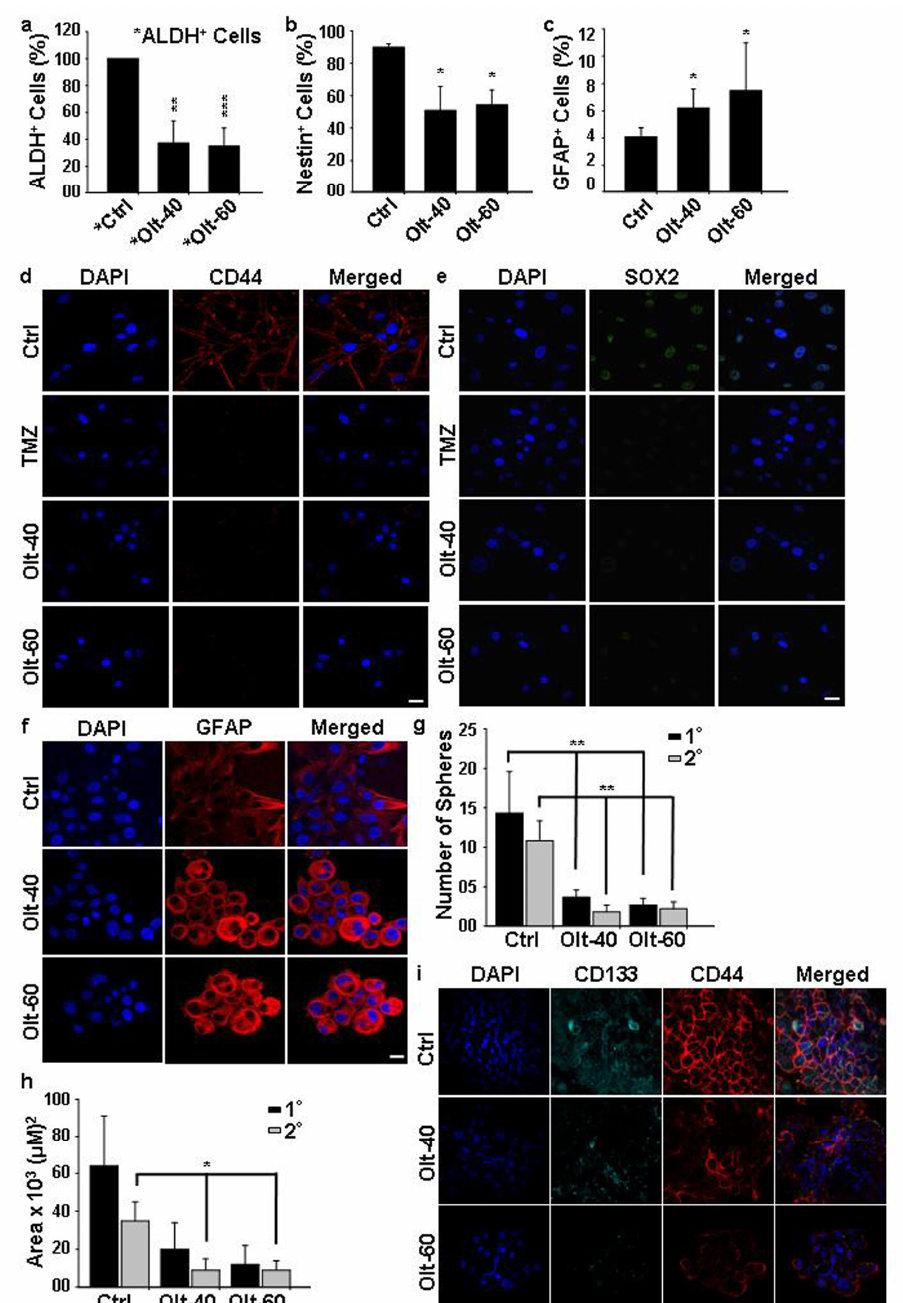
Figure 4. Influence of Olt on GSC population in vitro: ( a ) The ALDH + cells representing the GSCs pool from U-87 MG cells, following their purification by FACS and reseeding, displayed a significant reduction in ALDH + cells upon their exposure to the Olt for 48 h. ( b , c ) Olt exposure of U-87 MG cells for 48 h in culture decreased the number of Nestin + cells ( b ) but increased the GFAP + cells (c ). ( d , e ) The immunostained pattern also revealed a reduction in U-87 MG cells exhibiting stem cell markers such as CD44 ( d ) and SOX2 ( e ) expression upon Olt exposure. ( f ) Olt exposure of U-87 MG cells led to an increase in GFAP, a mature astroglial marker, expression in them compared to untreated Ctrl. ( g , h ) Decrease in the number ( g ) and size ( h ) of primary (1 ◦ ) and secondary (2 ◦ ) oncospheres in U-87 MG cells post-treatment of the Olt for 48 h. ( i ) Immunostaining of CD44 and CD133 in oncospheres developed showed a decrease in the expression of the CD133 and CD44 populations in the Olt-treated U-87 MG cells. Scale bar: 20 µ M. Data are presented as mean ± SEM (n = 4 in a – c , and 3 in g , h ). * p ≤ 0.05, ** p ≤ 0.01, *** p ≤ 0.001 compared to the untreated